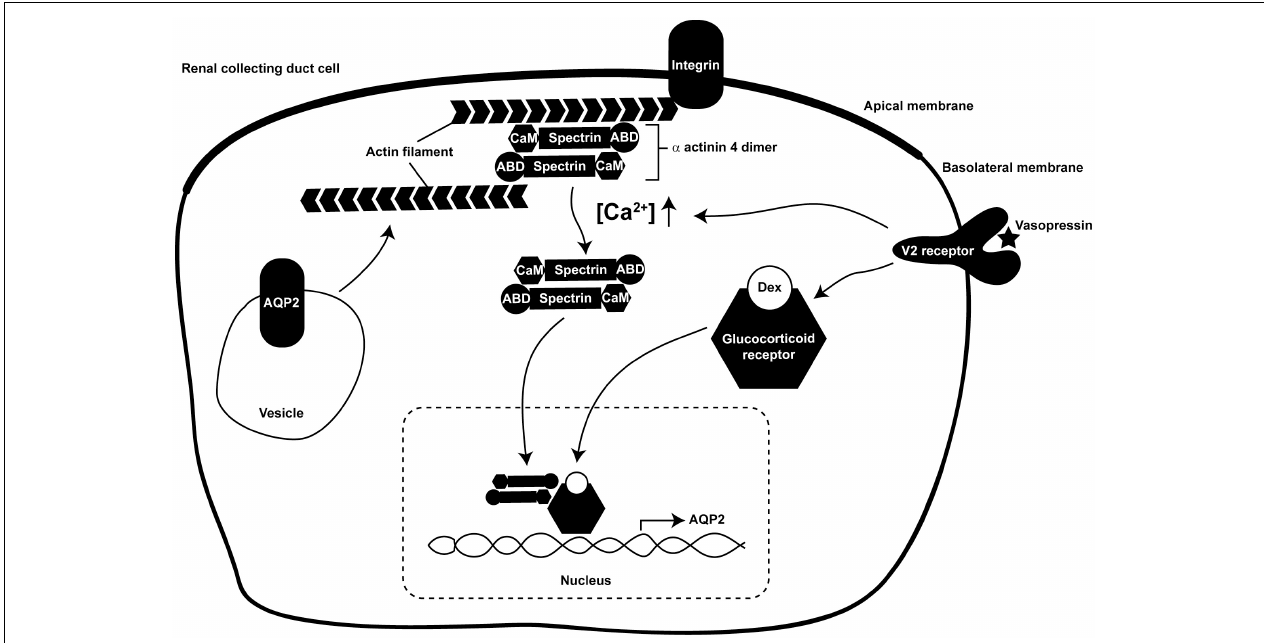
FIGURE 8 | A model illustrates dual functions of α -actinin 4 in vasopressin short-term and long-term actions in the kidney collecting duct cells. ABD, actin-binding domain; CaM, calmodulin-like domain; Dex,